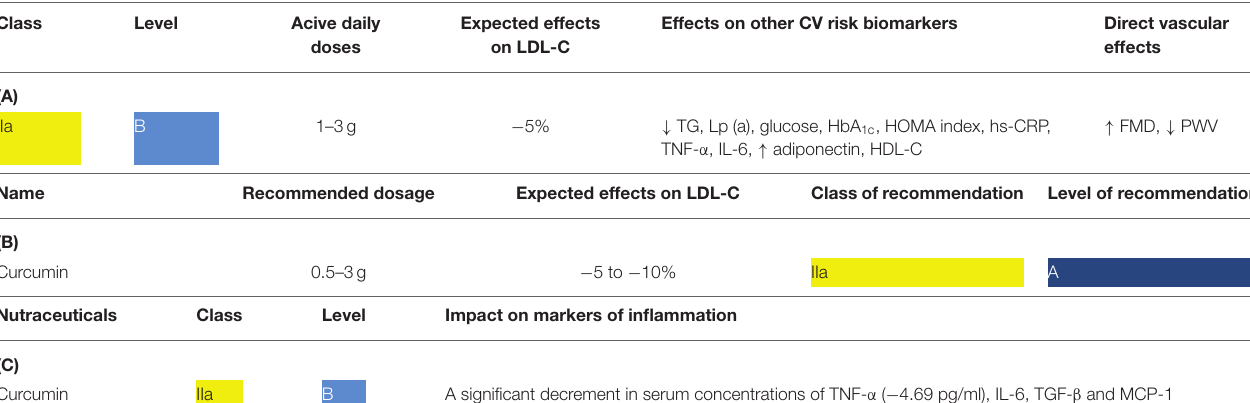
TABLE 1 | Clinical relevance of curcumin based on existing recommendations: (A) lipid lowering properties based on the International Lipid Expert Panel (ILEP) position paper (15), (B) the place of curcumin in lipid-lowering therapy based on the Polish guidelines (16), (C) the role of curcumin in managing inflammatory parameters based on the ILEP position paper (17).